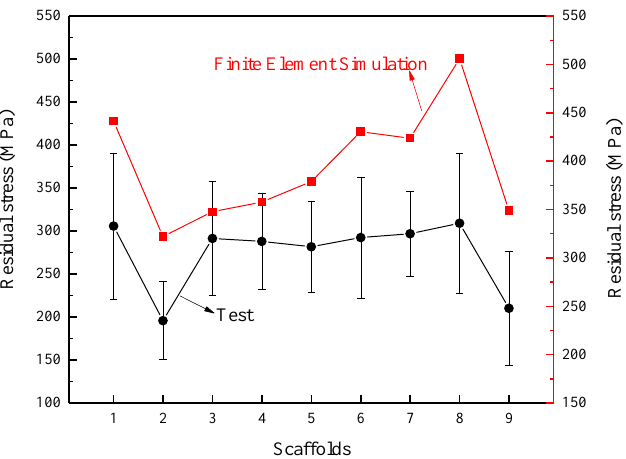
Figure 12. Residual stress analysis